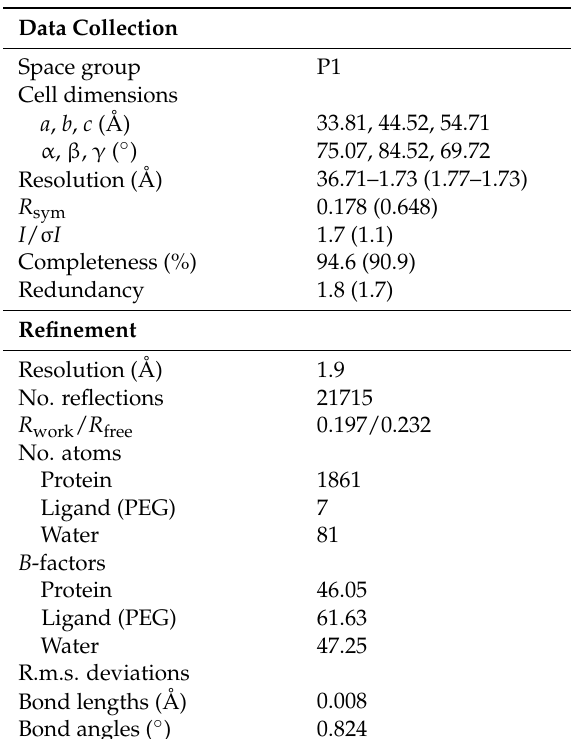
Table 1. Archaeoglobus fulgidus SBDS crystallographic data collection and refinement